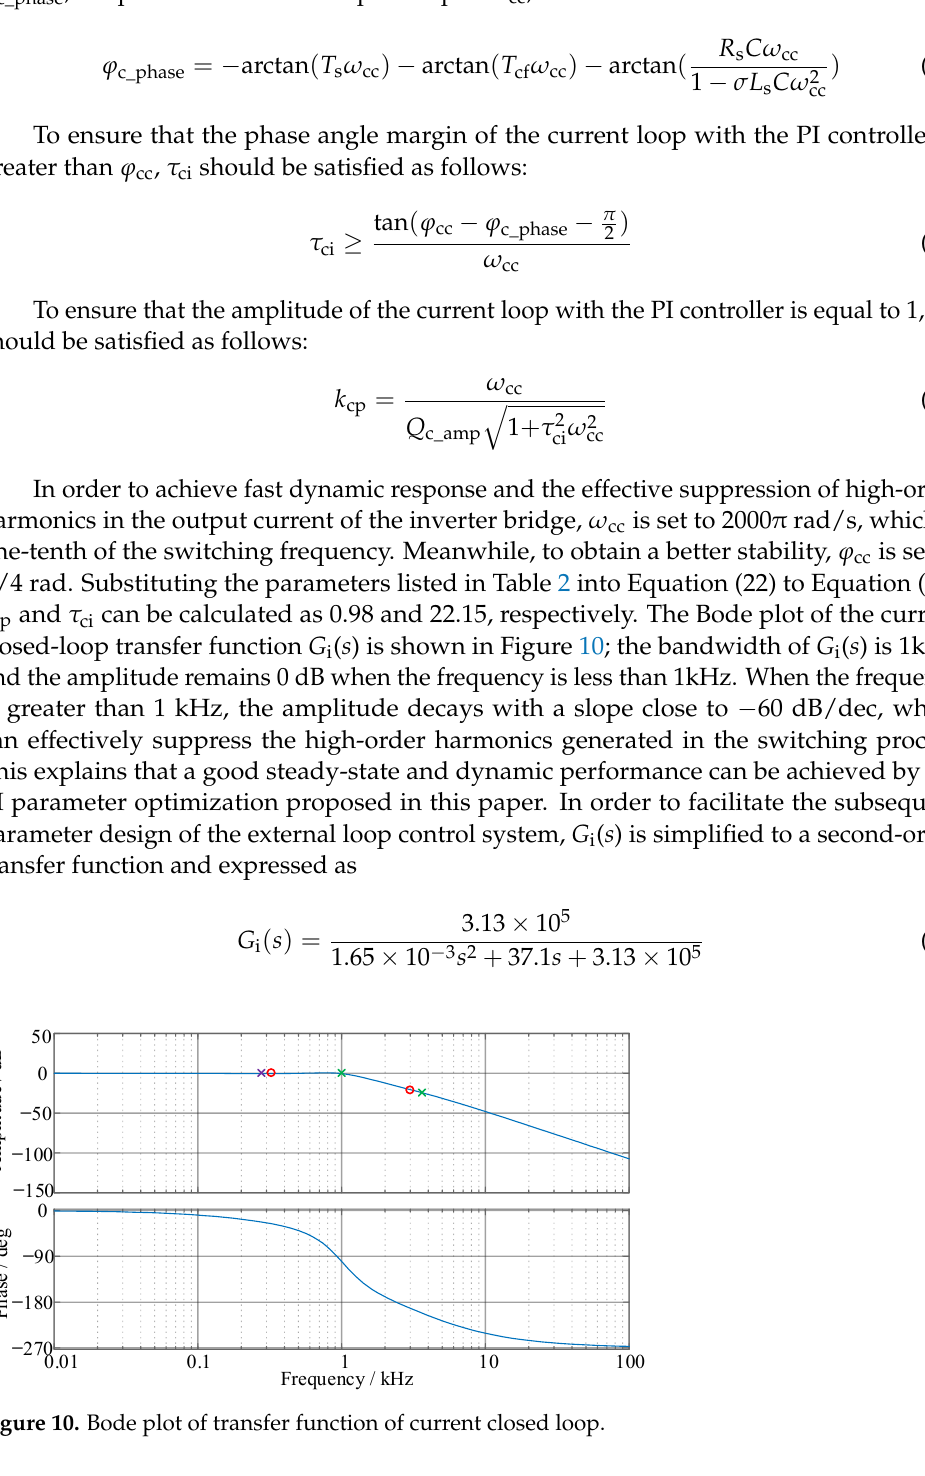
r ψ Figure 11. The control diagram of the flux loop. To simplify the design method of the control parameters, zero − pole cancellation is adopted, and